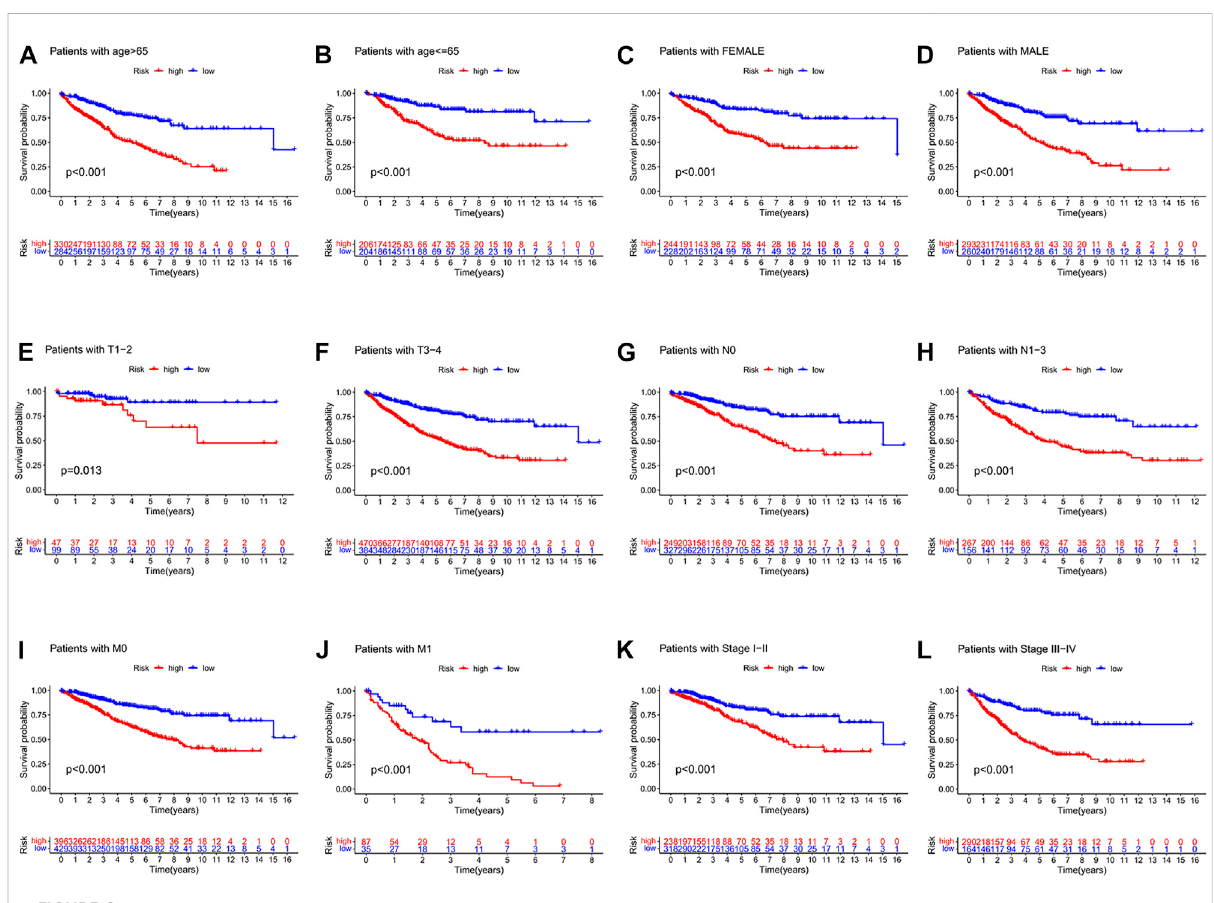
FIGURE 8 (A-L) visualized the risk score signature being applied to patients with different clinical subgroups, including different ages, different genders, differentT-stages, different N-stages, differentM-stages,and different pathological stages. (A) Patients with age > 65. (B) Patients with age & 65. (C) Femalepatients. (D) Malepatients. (E) PatientswithstagesT1-2. (F) PatientswithstageT3-4. (G) PatientswithstageN0. (H) PatientswithstagesN1-3. (I) Patients with stage M0. (J) Patients with stage M1. (K) Patients with stages I-II. (L) Patients with stages